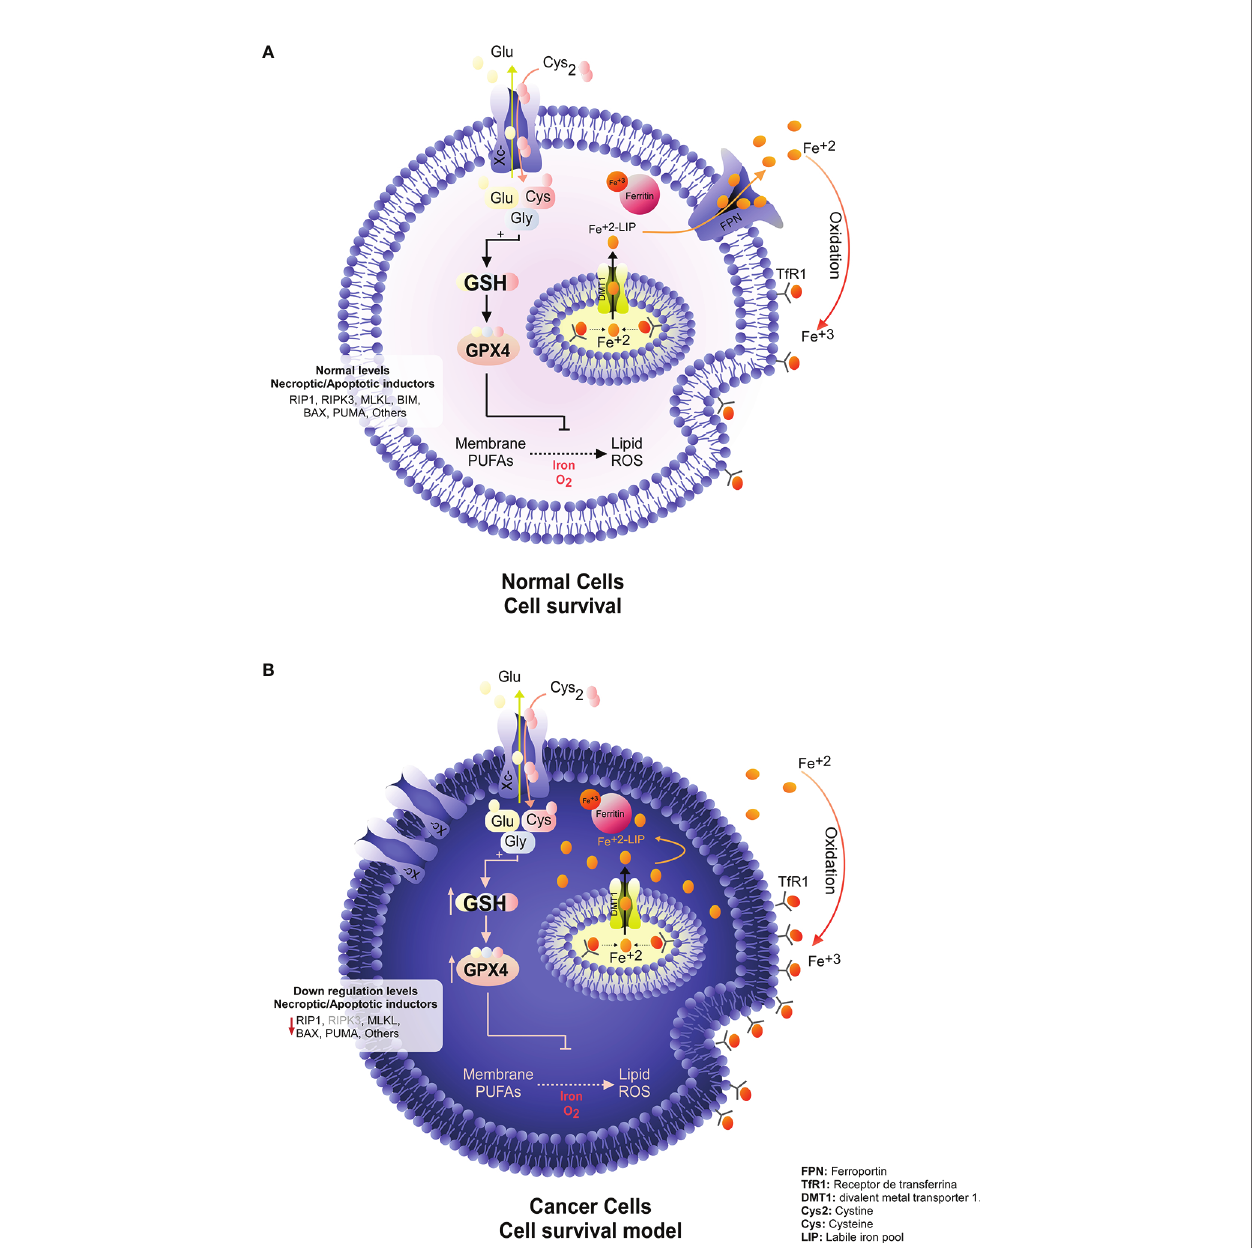
FIGURE 1 | Survival programs in normal and tumor cells. (A) Under physiological conditions, normal cells maintain stable levels of death-executing proteins while maintaining a constant balance of nutrients and trace elements, promoting cell survival. (B) To avoid death, tumor cells activate various mechanisms, such as decreasing the expression of proapoptotic and necroptotic genes while increasing antioxidant defense by increasing GSH synthesis and GPX4 levels. In this way, ROS are ef fi ciently eliminated, avoiding the damage produced by the accumulation of iron due to low FPN levels. This death evasion program makes many types of cancer highly dif fi cult to treat, as classical apoptosis induction therapies fail because the machinery for the execution of this pathway is not available. FPN, Ferroportin; TfR1, Transferrin Receptor 1; DMT1, Divalent Metal Transporter 1; Cys2, Cystine; Cys, Cysteine; LIP, Labile Iron